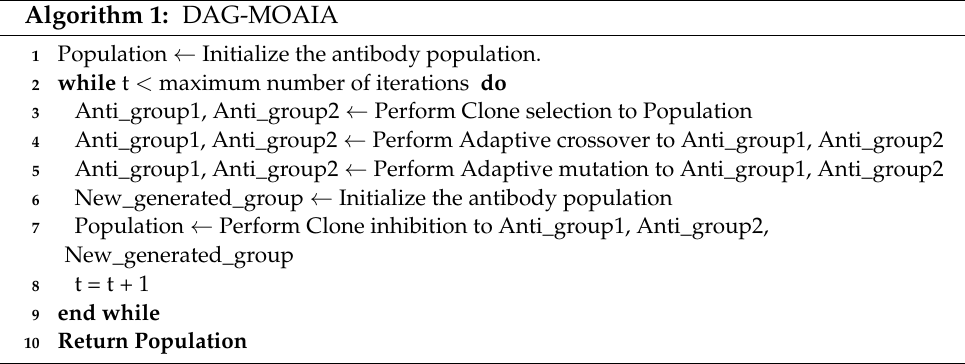
Figure 2. Iterative process of antibody population from generation t to generation t + 1. Algorithm 1: